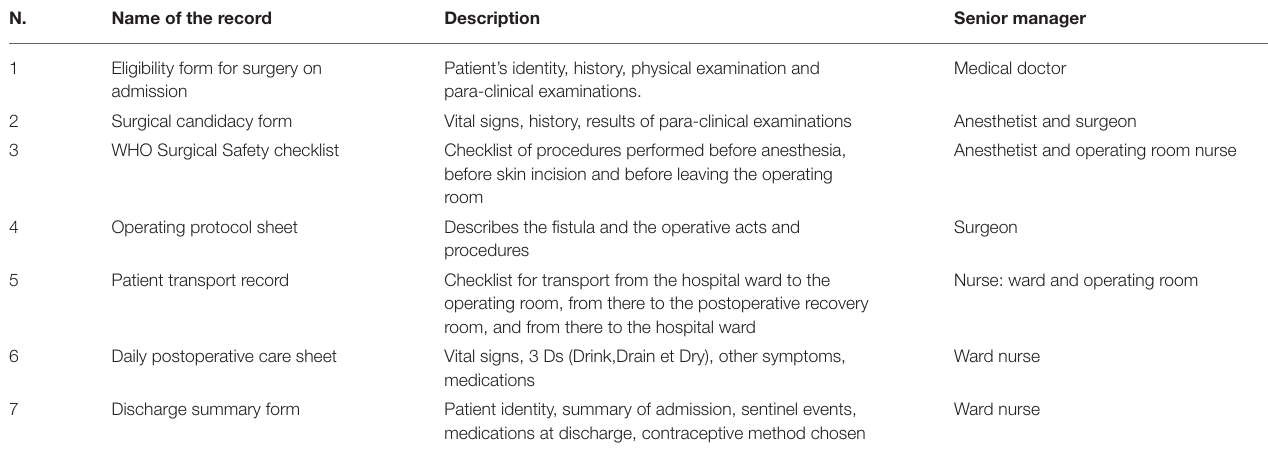
TABLE 1 | Forms included in the Client Tracker.